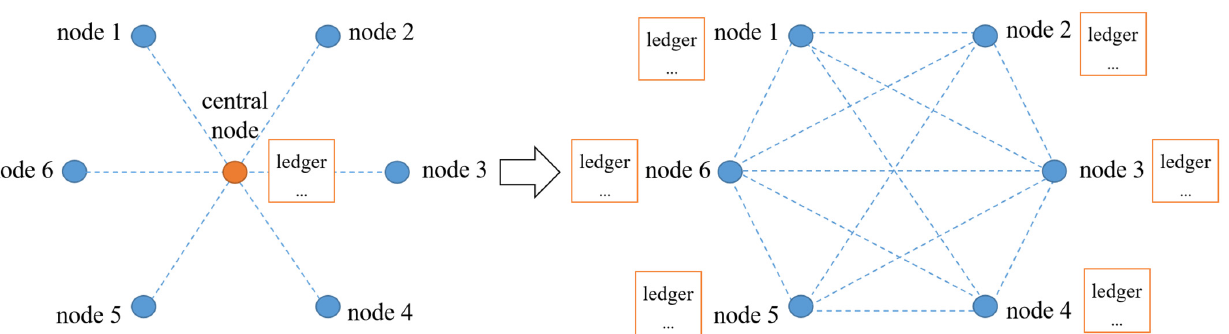
Figure 1. Comparison of traditional storage and distributed